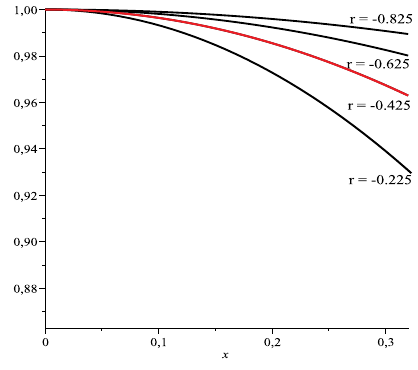
Figure 3. Approximat series solutions of f ( η ) to equation (2.5) and for different values of r when A = 1 and B = 0. Note the red curve is for r = − 0 .